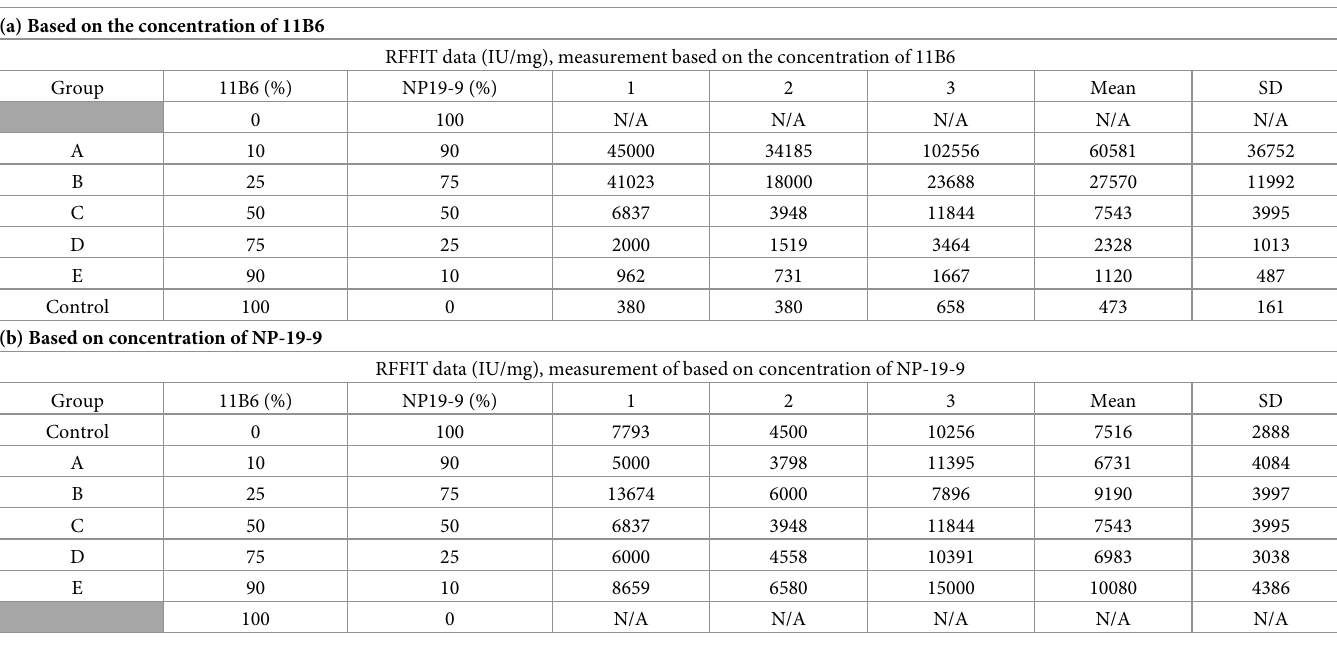
Table 7. Interference test with CVS-11 rabies virus strain by the RFFIT. (a) Based on the concentration of 11B6 RFFIT data (IU/mg), measurement based on the concentration of 11B6 Group